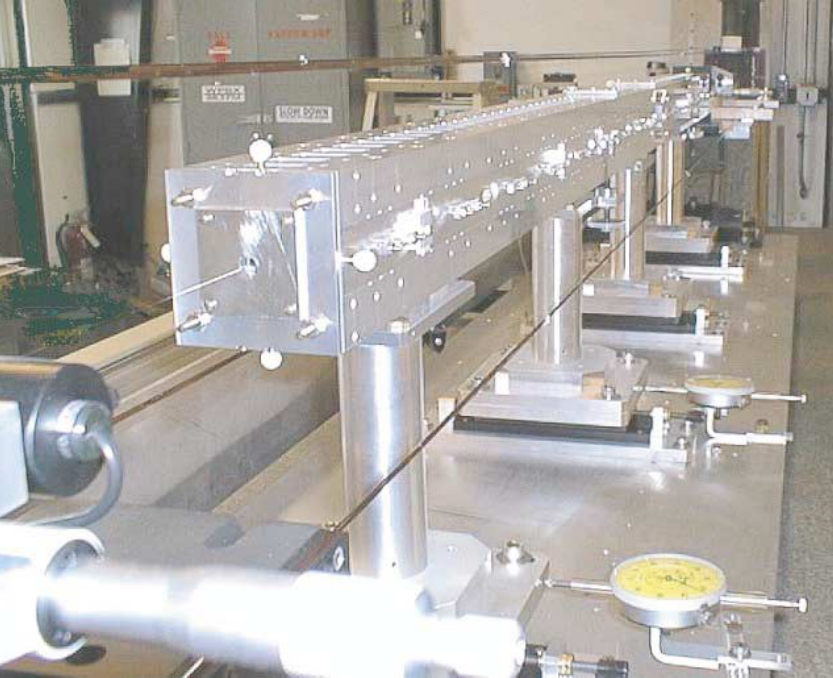
FIG. 6. (Color) Two segments of the VISA undulator mounted on the stretched wire testing stand. The wire may be seen passing down the axis of the undulator.